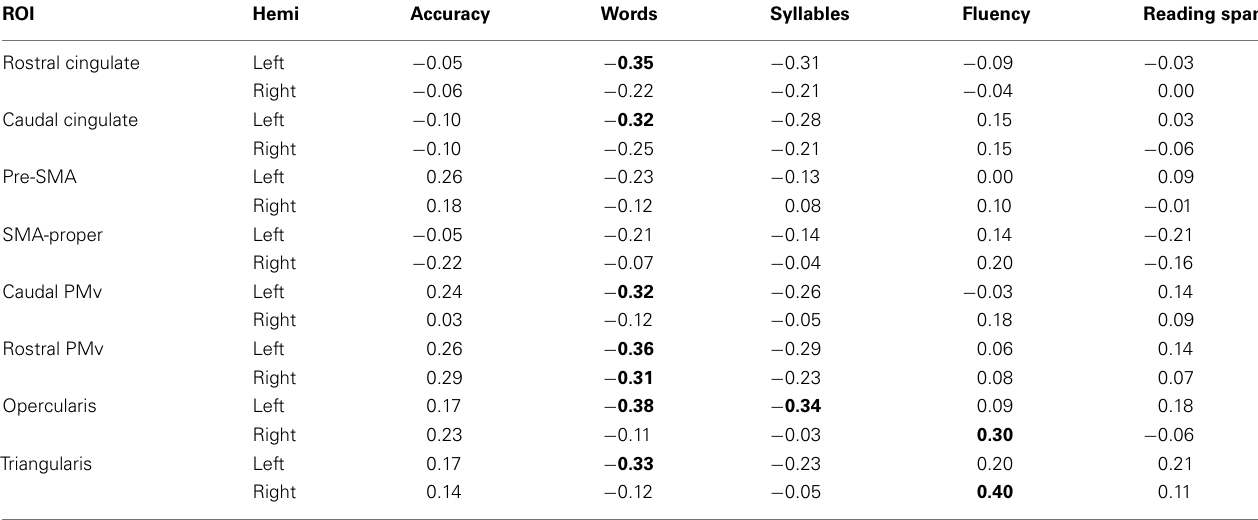
Table 5 | Brain/behavior correlations.